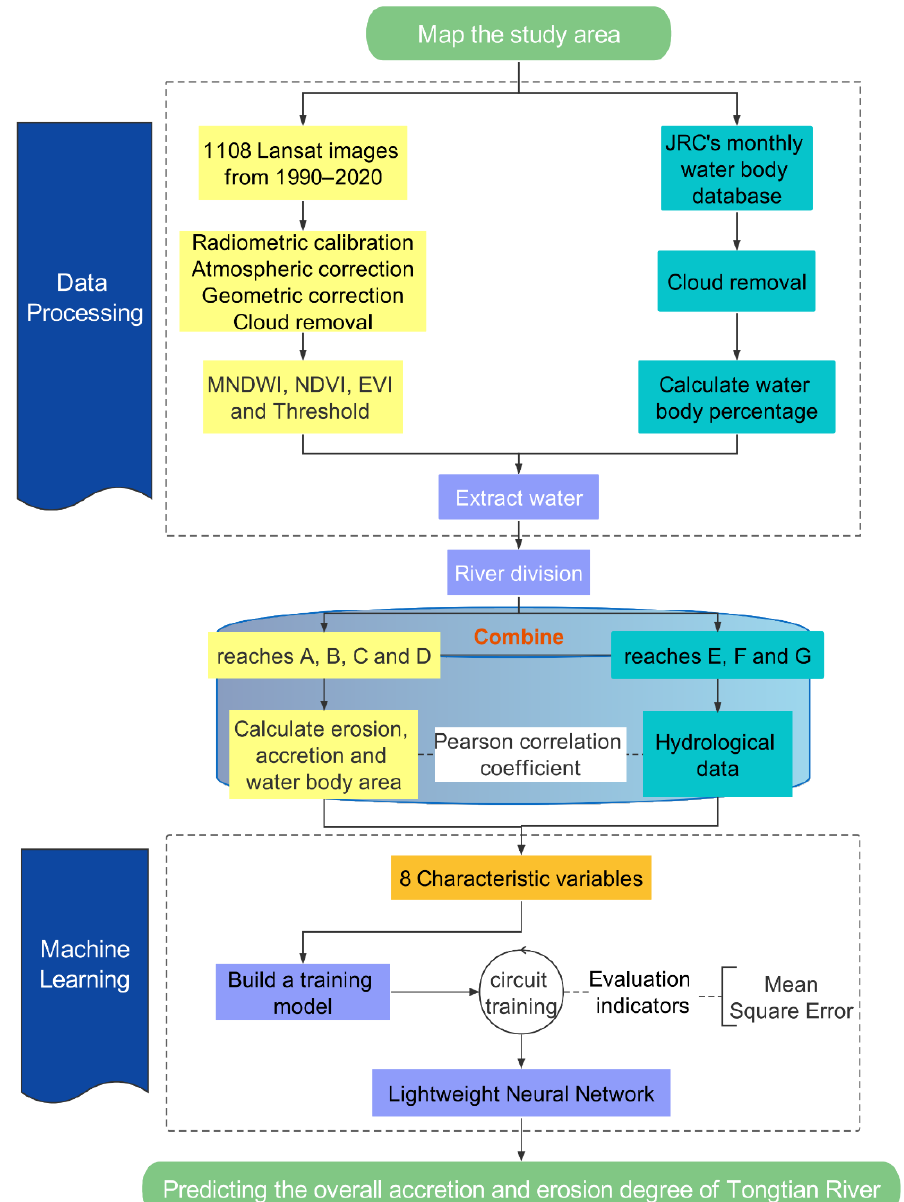
Figure 2. Flowchart of methods and techniques in this study.